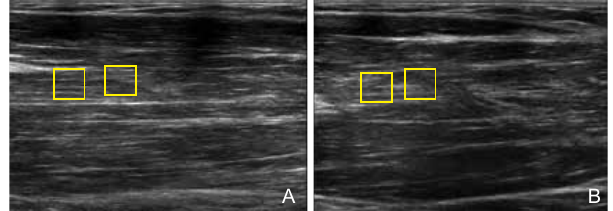
Figure 2 Textural characteristics changes of biceps brachii on high Figure 3 Textural characteristics changes of biceps brachii on high frequency ultrasonograms in healthy male volunteers under different frequency ultrasonograms in healthy female volunteers under different physiological states (yellow box indicated ROI). (A) Biceps brachii relaxation without load bearing; (B) Biceps brachii contraction in load state Table 4 Eight texture features of biceps brachii in healthy volunteers of different genders under relaxation ( x ± s , n =30 samples) Parameters